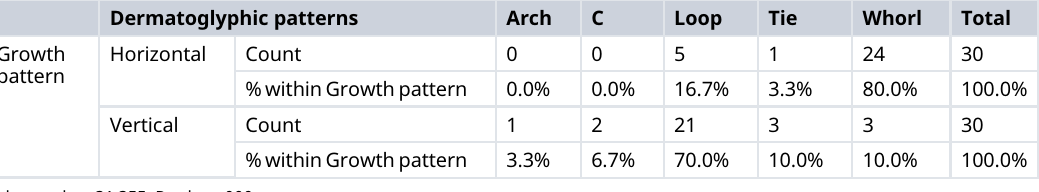
Table 4. The Fisher ’ s exact test between the horizontal and vertical groups (Left